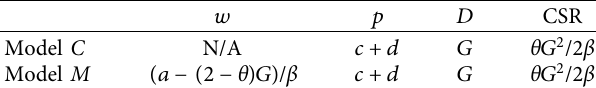
Table 3: The equilibrium strategies in Models C and D in this carbon cap-and-trade